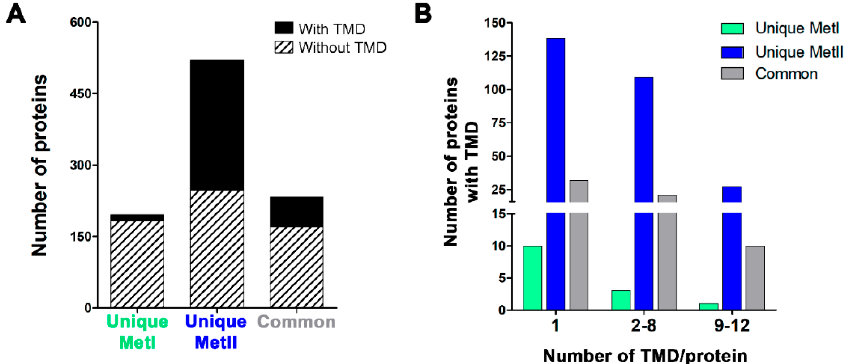
Figure 4. Analysis of transmembrane domain (TMD) present in unique and common mast cell lipid raft proteins identified using Method I or Method II. Prediction of the presence of TMD was done using the TMHMM server v2.0. ( A ) Number of proteins with and without TMDs is shown. ( B ) The number of proteins with TMD versus the number of TMD/protein is given.